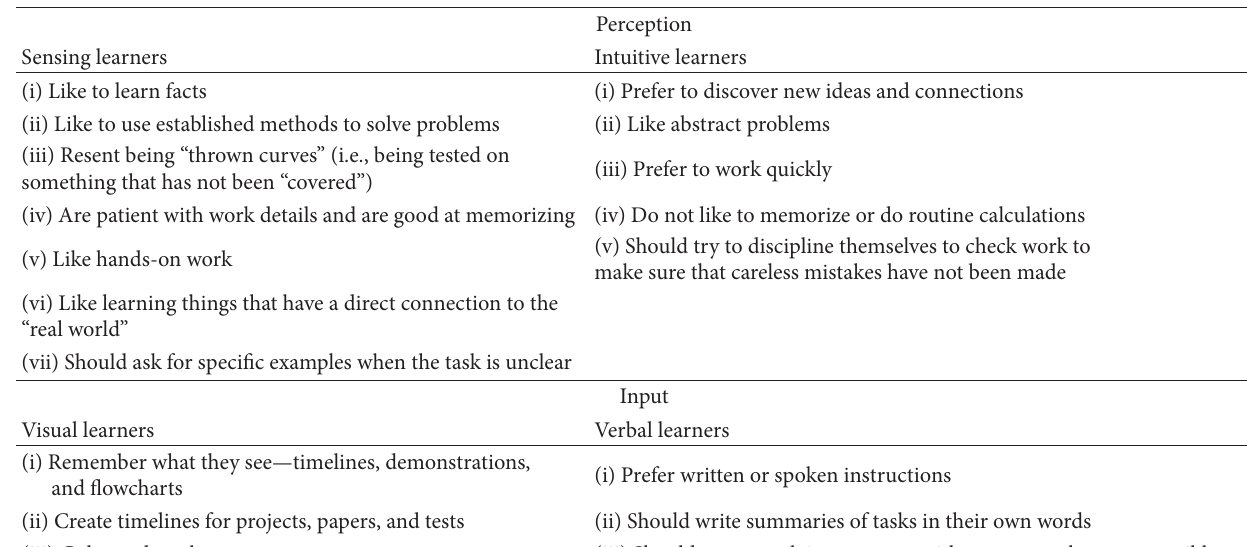
Table 1: The index of learning style survey [8].